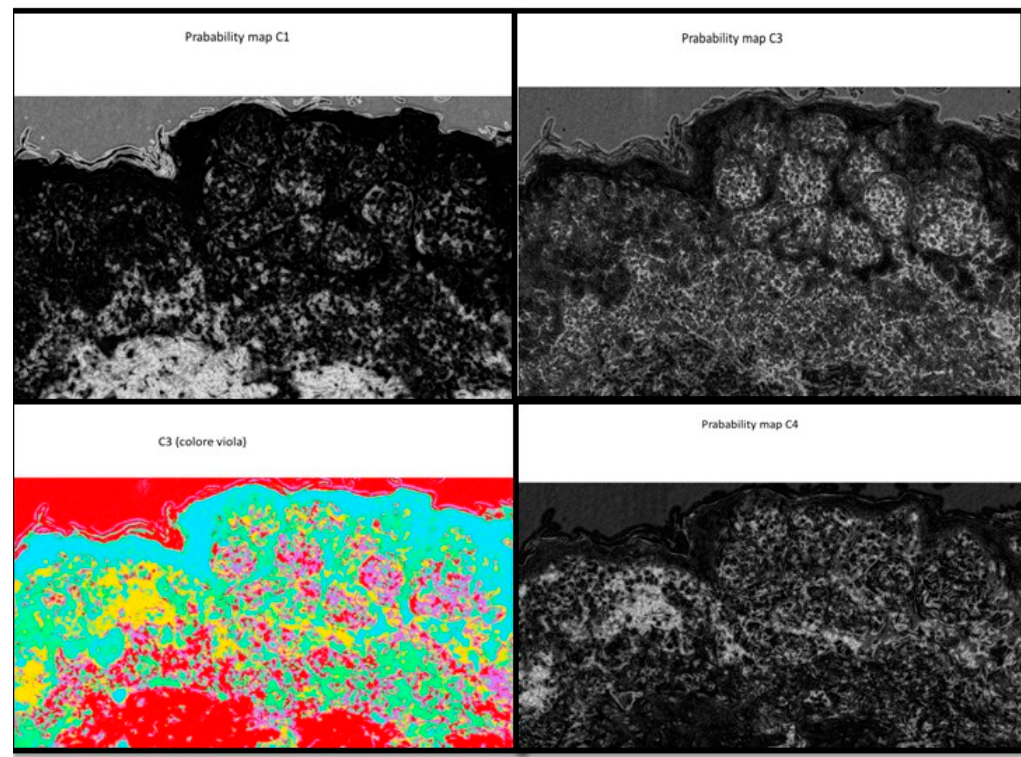
Figure A2. Example of distribution of the probability classes from C1 (low probability of recognition of the anomaly, black shade) to C4 (high probability of recognition of the anomaly, white shade). Figure A2 is an example that represents different classes, where each one is a proba- bilistic image with the white color representing the higher probability value to find spe- cific class features. Alternatively, all classes are identified in the same image by different colors.